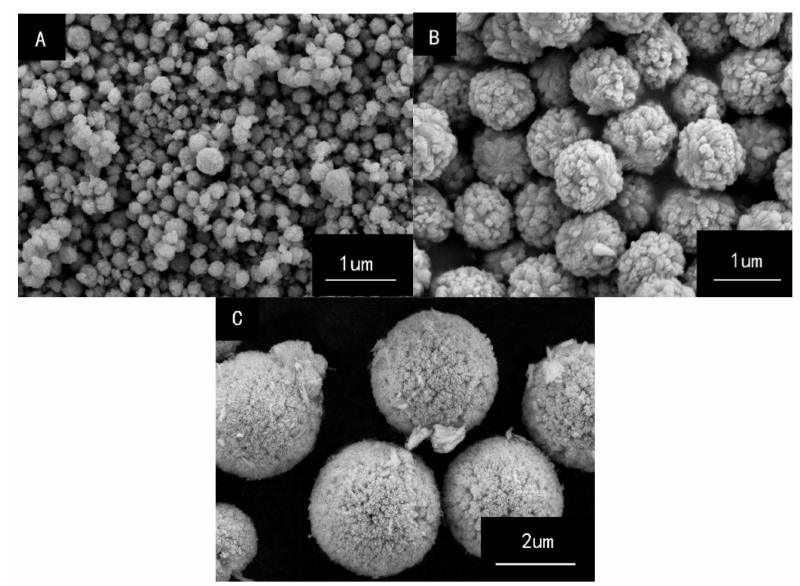
Figure 4. SEM of BaSO 4 at different reaction temperatures: ( A ) 15 ◦ C, ( B ) 55 ◦ C, ( C ) 95 ◦ C.